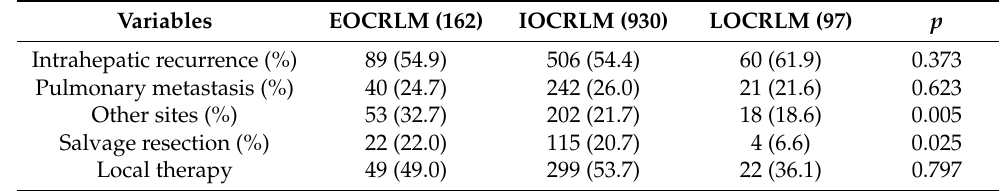
Table 3. Recurrence patterns and subsequent therapy in CRLM patients with different age